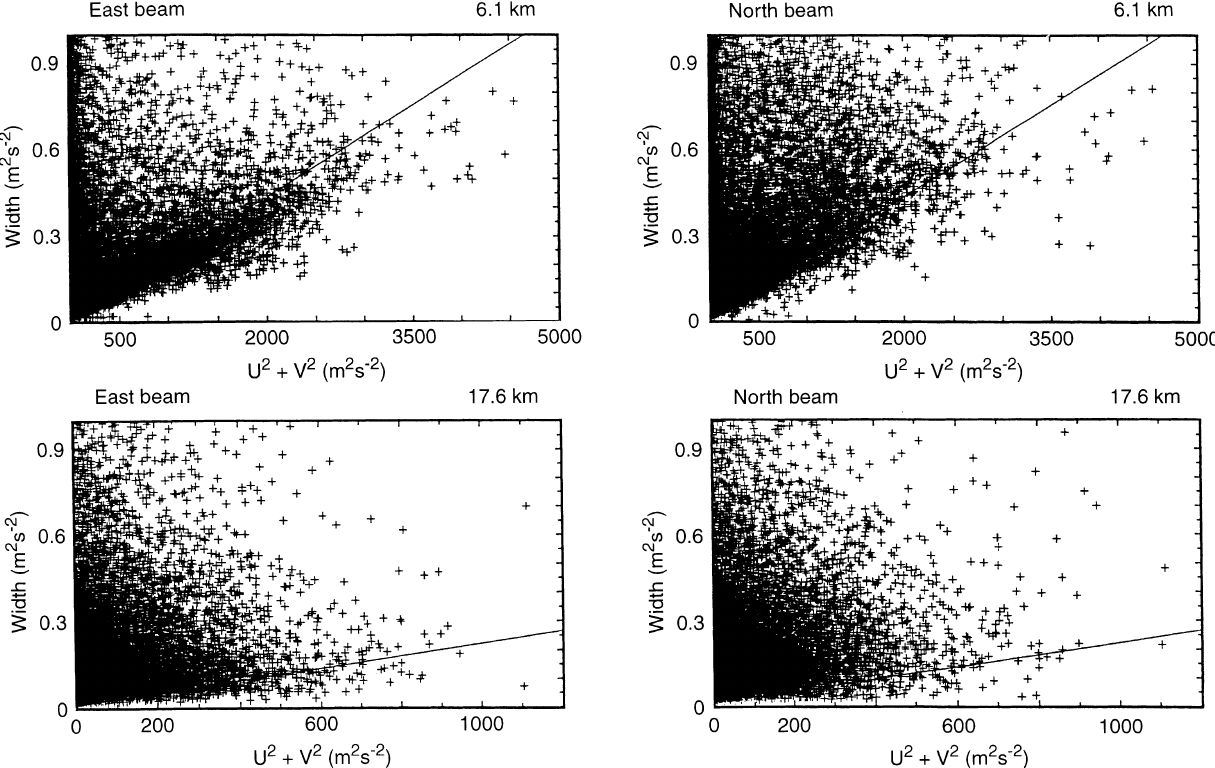
Fig. 6. Hourly means of the Doppler spectral widths observed at WSMR by the oblique beams in the (1) east-west and (2) north-south planes at 6.1 and 17 : 6km as a function of square of the observed horizontal wind speed ( U and V are observed zonal and meridional wind speeds, respectively). The solid line in each panel is the spectral broadening that would be expected due to beam-broadening e(cid:128)ects alone